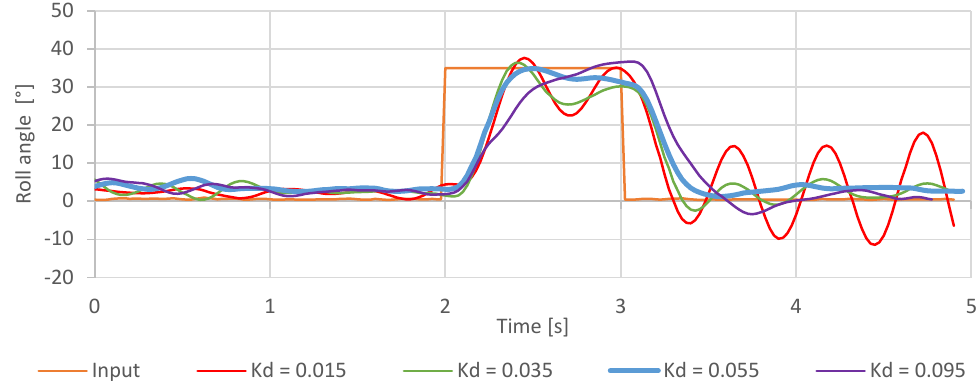
Figure 22. Step response of the roll axis controller for different Kd values.